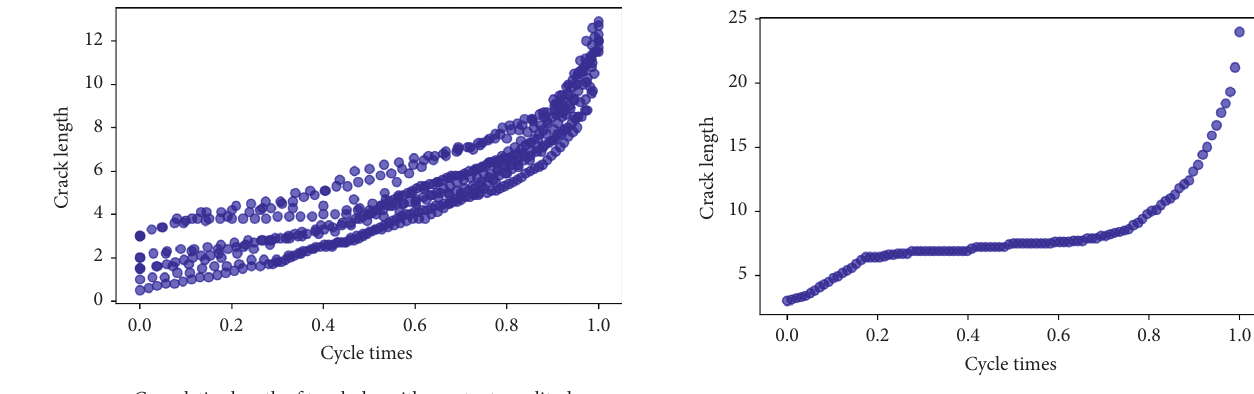
Figure 15: Cumulative length of three holes with variable amplitude.